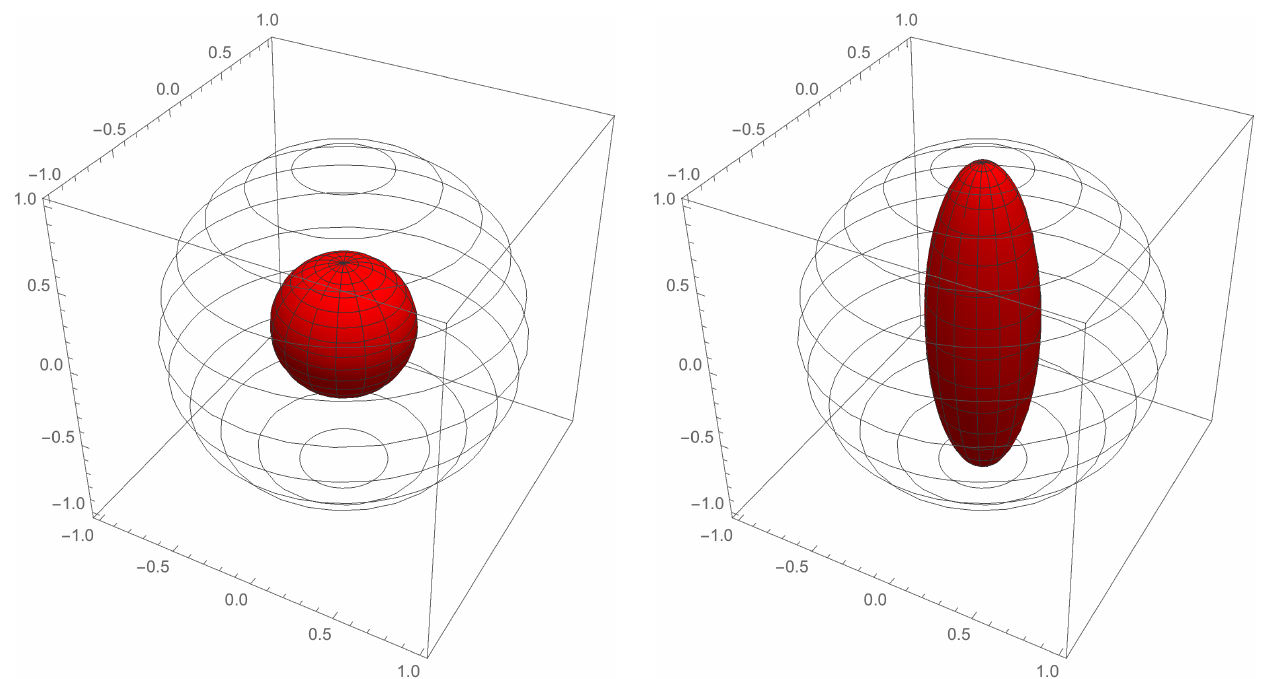
Figure 2: Action of a phase damping channel on the Bloch ball. The Bloch ball (outer ball of unit radius) is shown in white. The image is plotted in